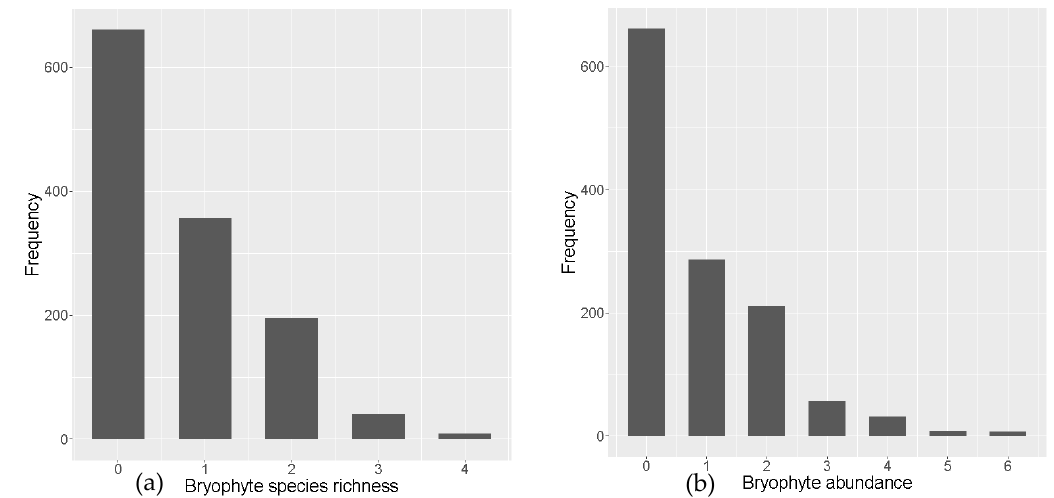
Figure 2. Frequency of the species richness ( a ) and abundance ( b ) of epiphytic bryophytes on Schima superba trees in an urban forest.